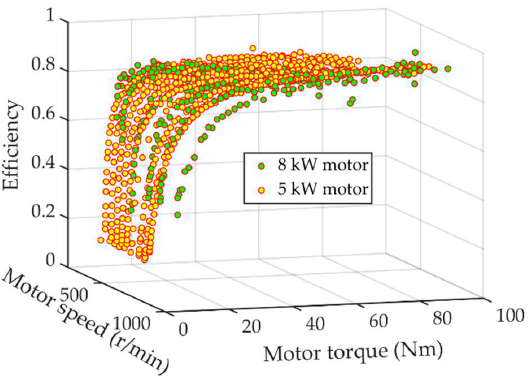
Figure 5. Measured results of efficiency of two motors.